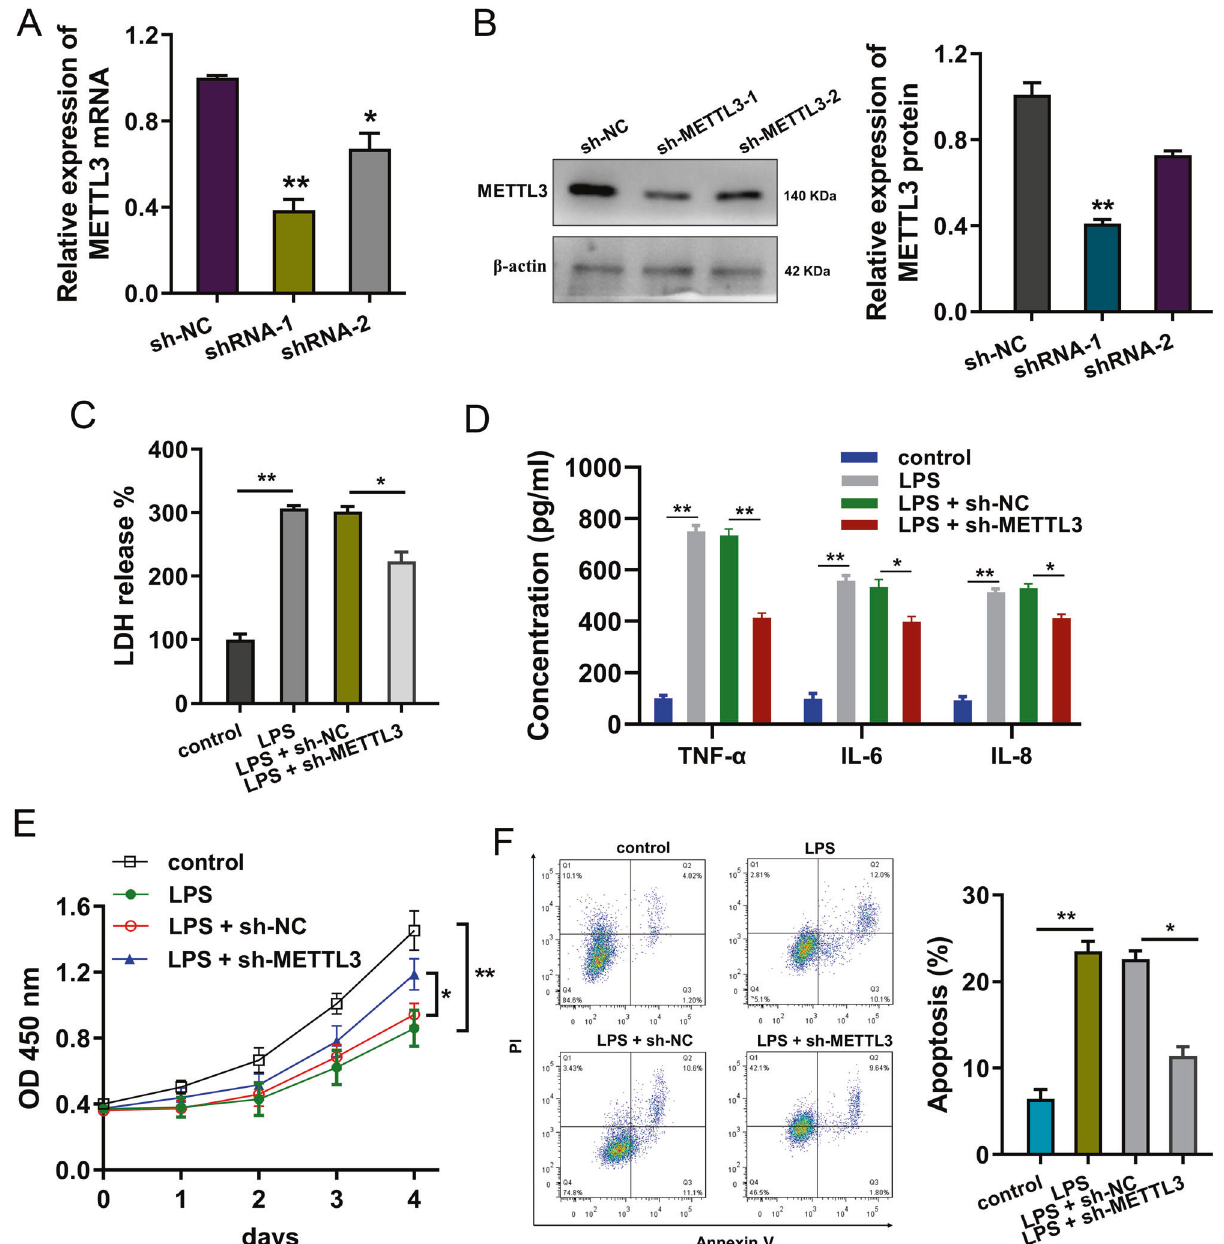
Fig. 2 METTL3 knockdown repressed the in fl ammatory damage of cardiomyocytes induced by LPS. A The silencing ef fi ciency was detected using RT-qPCR and ( B ) western blot for cardiomyocytes transfected with METTL3 knockdown (sh-METTL3) or controls (sh-NC). C The lactate dehydrogenase (LDH) release analysis was performed using microplate reader, including control, LPS, LPS + sh-NC, LPS + sh-METTL3. D ELISA analysis was performed to detect the levels of proin fl ammatory cytokines (interleukin (IL)-6, IL-8, and tumor necrosis factor-alpha (TNF- α )) for cardiomyocytes (H9C2), including control, LPS, LPS + sh-NC, LPS + sh-METTL3. E Proliferative ability using CCK-8 assay for the proliferation ability of cardiomyocytes, including control, LPS, LPS + sh-NC, LPS + sh-METTL3. F Flow cytometry for apoptosis analysis revealed the apoptosis of cardiomyocytes transfected with METTL3 knockdown (sh-METTL3) or controls (sh-NC) upon LPS administration. Biological experiments were performed in triplicate. Data were exhibited as Mean ± Standard Deviation (SD). ** p < 0.01, *p < assay (RIP-qPCR) showed that METTL3 interacted with HDAC4 mRNA via molecular bindings (Fig. 3E). Taken together, these fi ndings suggested that HDAC4 acted as a target of METTL3 in cardiomyocytes.